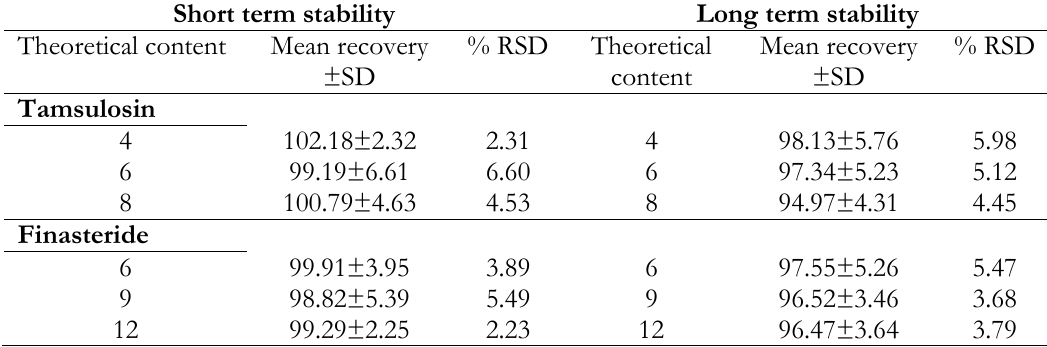
Table VI. Stability study Short term stability Long term